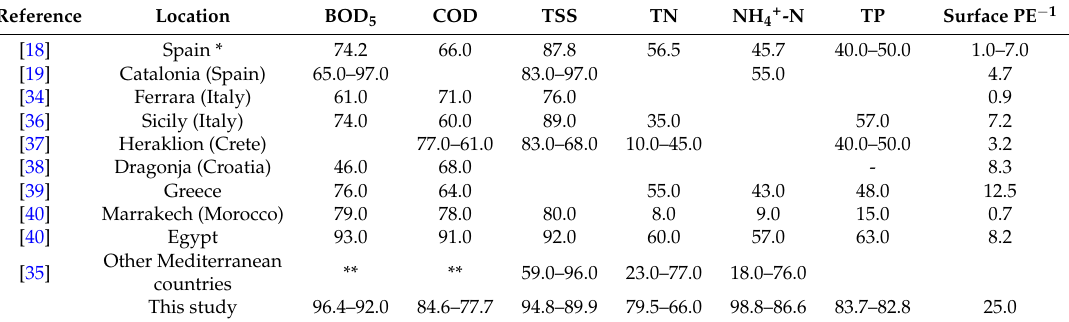
Table 3. HF-CW performances (percentage abatement %) in the Mediterranean countries planted with Phragmites australis and surface PE − 1 (m 2 · PE − 1